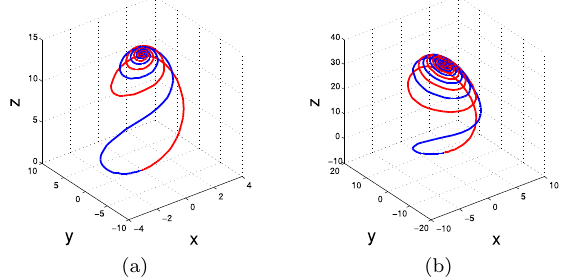
Figure 3. Two orbits of system (1.3) for the parameters a = 2, b = 3 and c = 0, time integration: [0 , 250] and the initial values: (a) ( x 0 ,y 0 ,z 0 ) = ( ± 3 . 82 × 1 e − 5 , ± 6 . 18 × 1 e − 5 , 0), (b) ( x 0 ,y 0 ,z 0 ) = ( ± 3 . 82 × 1 e − 5 , ± 6 . 18 × 1 e − 5 , − 3). These figures show the existence of two singularly degenerate heteroclinic cycles of system